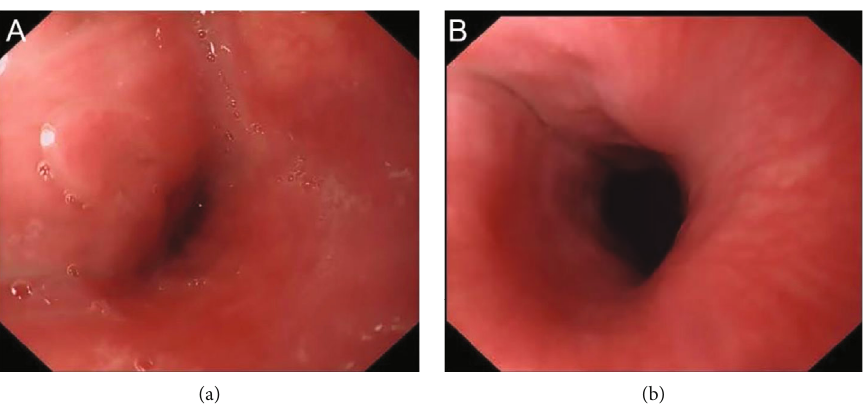
Figure 7: One year after operation, scar formation at esophageal introitus was found by gastroscopy. No stricture was found in the esophageal lumen of each